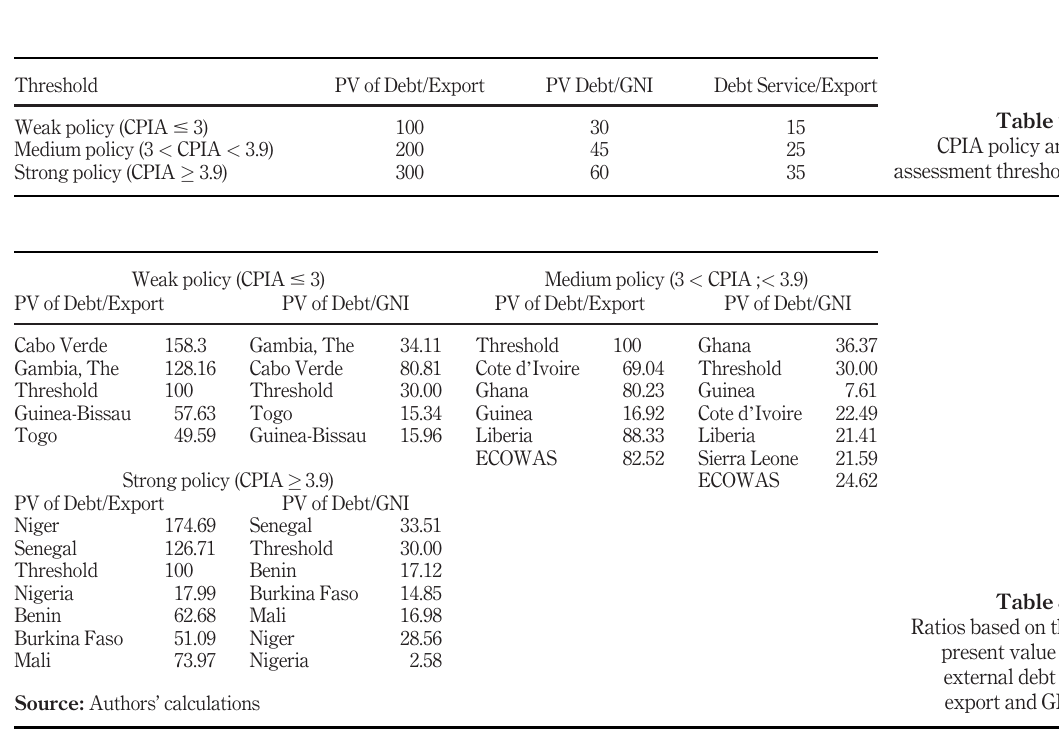
Table 8. Ratios based on the